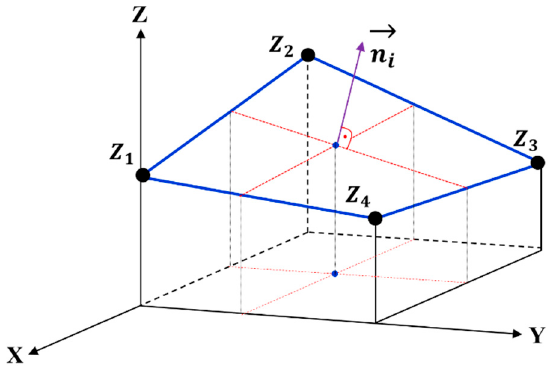
Figure 2. Normal vector of the tangential plane at a certain location of a bilinear surface.